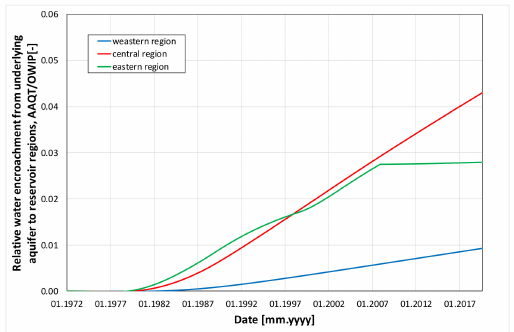
Figure 21. Relative water encroachment from underlying aquifer to reservoir regions.